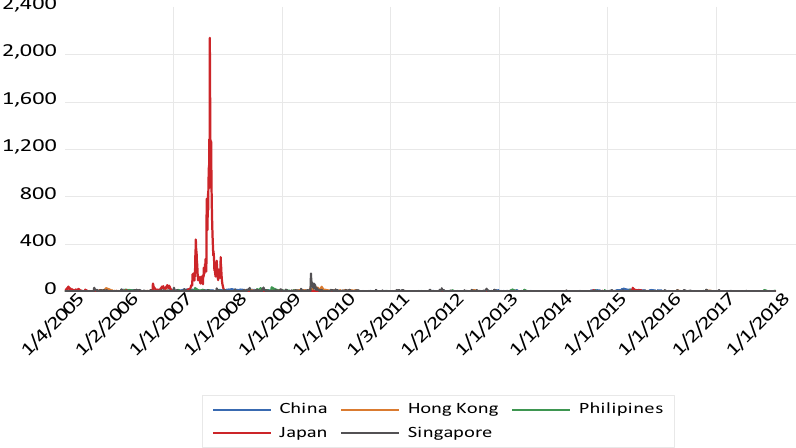
Fig. 6 Combined time-varying correlations of individual country Water Index Returns based on DCC-GARCH